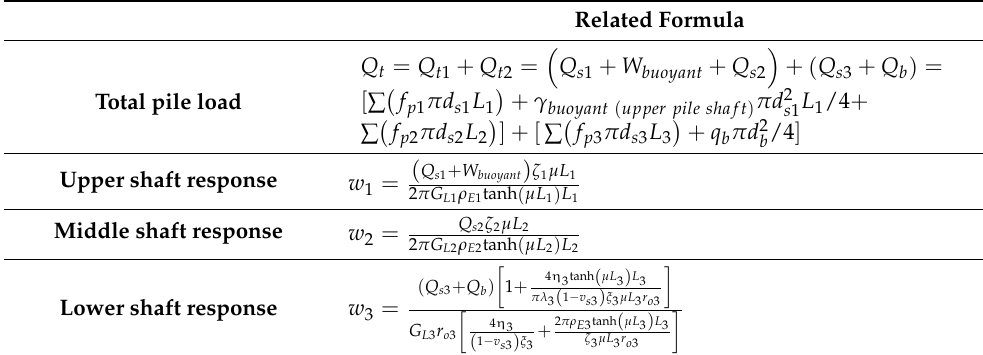
Table 5. Modified closed-form analytical solutions for two cases of O-cell pile loading.